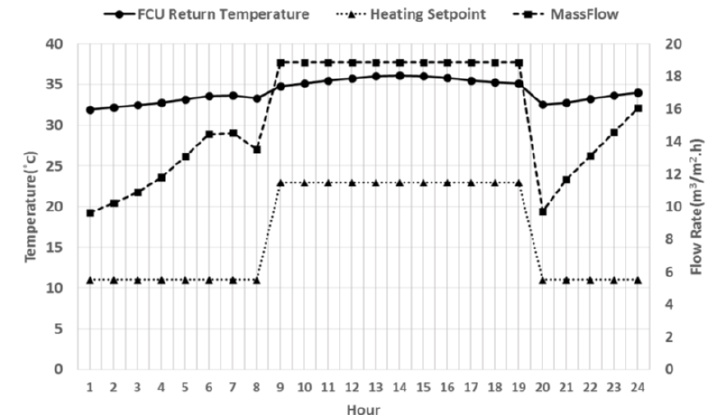
Figure 7. FCU hot water supply flow rate and return water